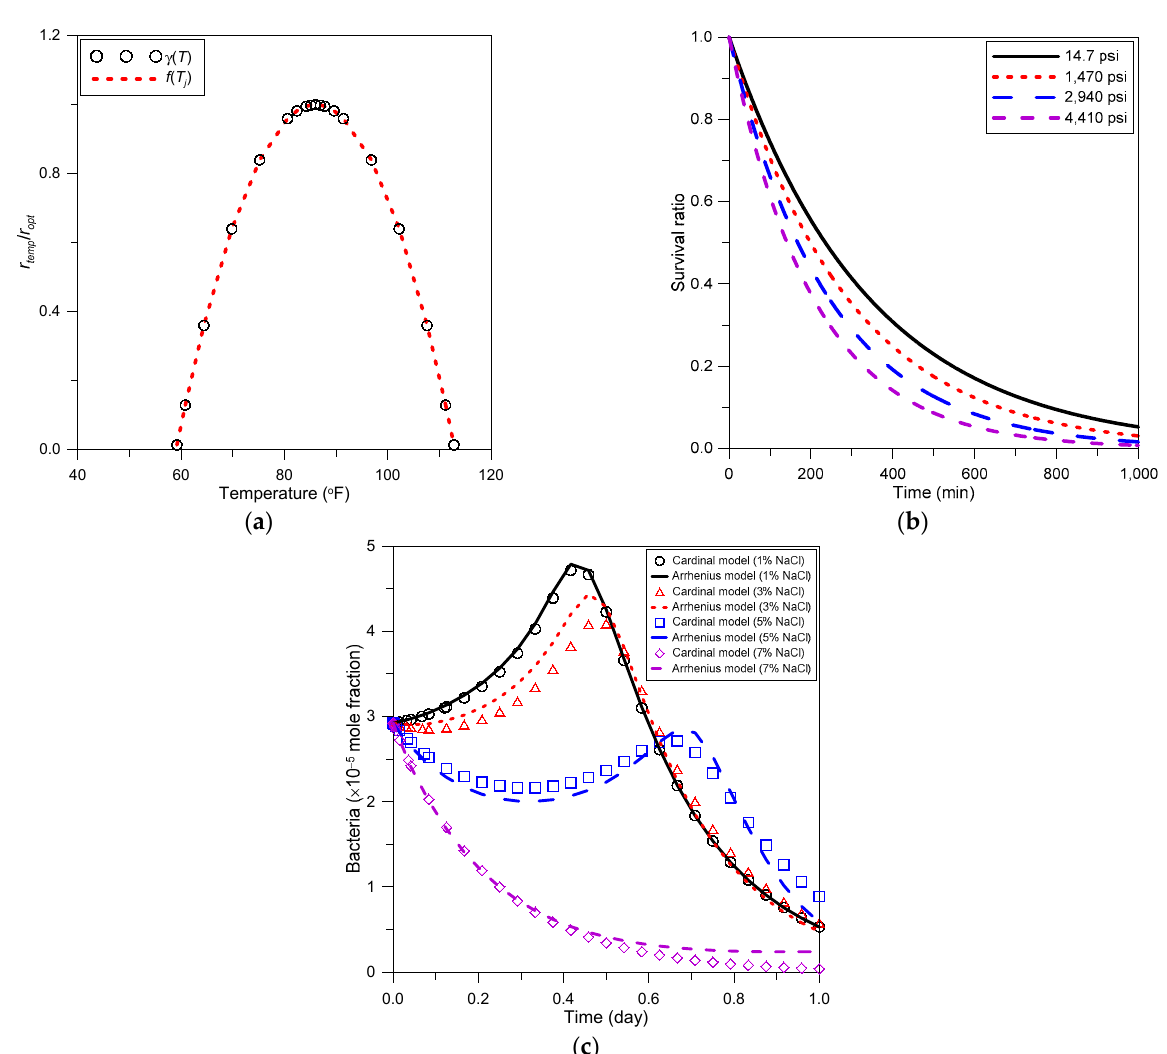
Figure 2. Results of environmental factor reflection model: ( a ) temperature effect, ( b ) pressure effect, ( c ) salinity effect.